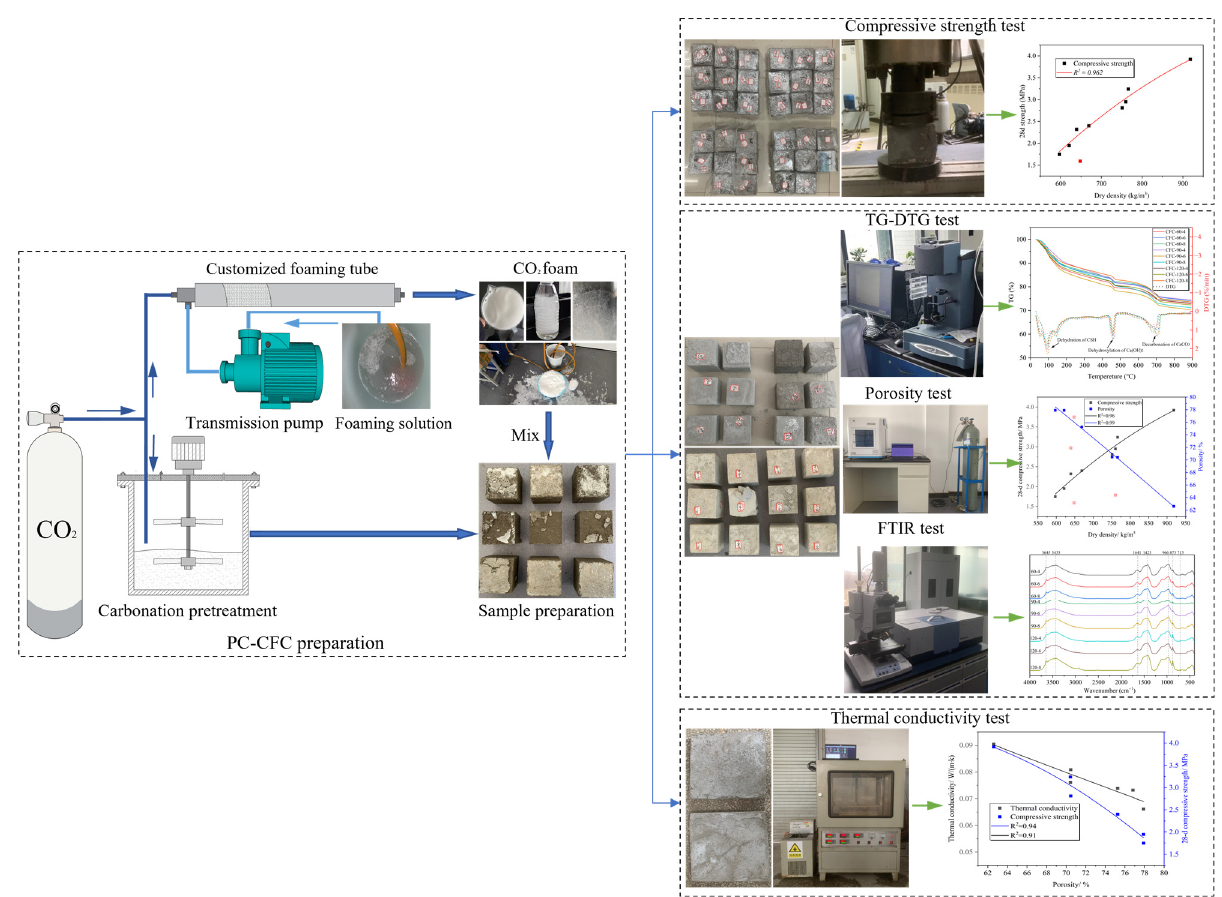
Figure 1. Experimental device and